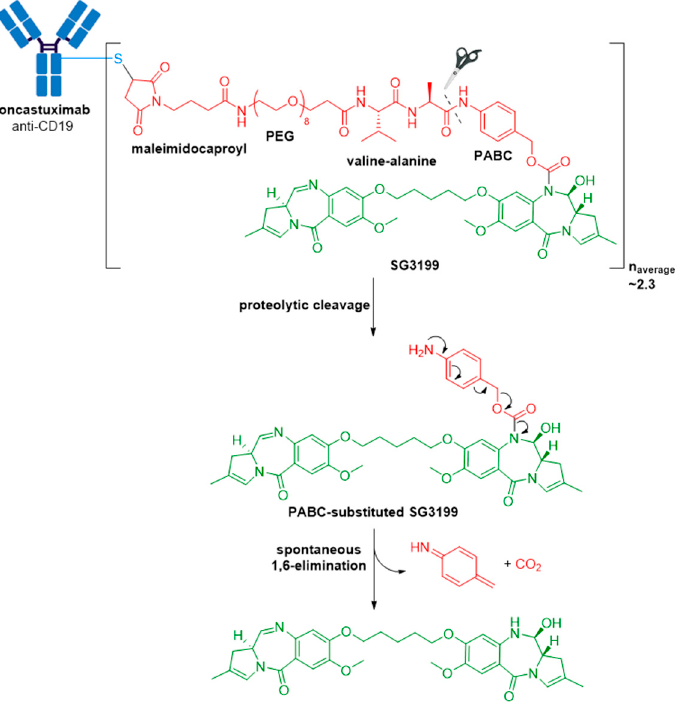
Figure 14. Structure of Zynlonta ® (loncastuximab tesirine-lpyl). The antibody is shown in blue, and chemical structures for linker and payload are in red and green, respectively. PEG, polyethyleneglycol. Spontaneous 1,6-elimination mechanism for the PABC-substituted SG3199, leading to release of SG3199, p -iminoquinone methide, and carbon dioxide.